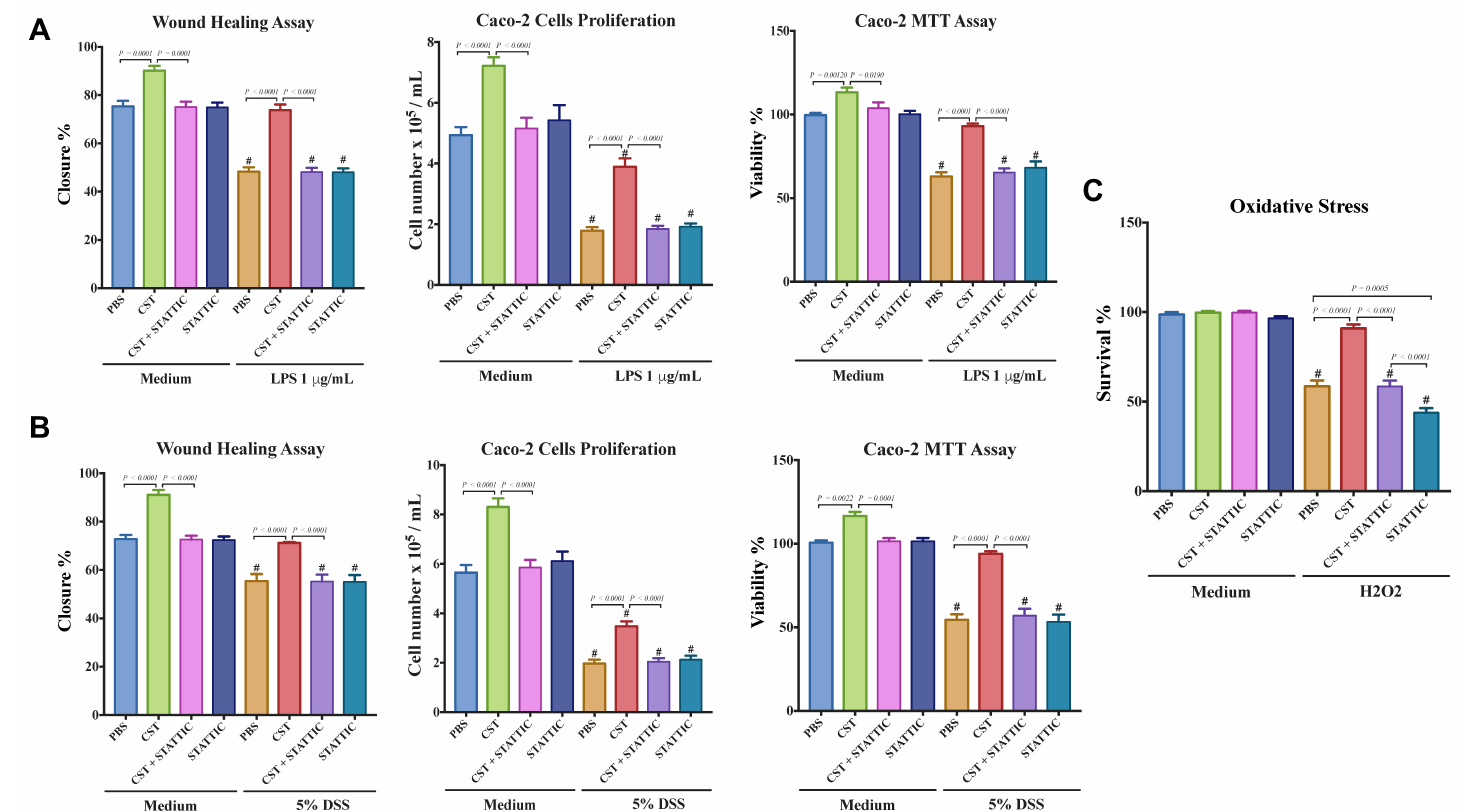
Figure 9. Catestatin (CST) enhances migration, proliferation, and viability of a colonic cell line in inflammatory conditions. Caco-2 cells were pretreated with 1 × phosphate buffer saline (PBS) or CST (100 ng/mL) for 24 h, then challenged with lipopolysaccharide (LPS) (1 µ g/mL) or 5% DSS) for an additional 24 h in the presence or absence of a STAT3 inhibitor (10 − 5 M, STATTIC; Sigma, Mississauga, ON, Canada). ( A , B ) Epithelial cell migration assessed by the wound healing assay, intestinal epithelial cell proliferation, and epithelial cell viability assessed by the 3-(4,5-dimethyl thiazolyl-2yl)-2,5-diphenyl tetrazolium (MTT) assay; ( C ) Epithelial cells oxidative stress assay show survival data from cultures treated with normal medium (control) or 200 mmol/L H 2 O 2 in the presence or absence of a STAT3 inhibitor (10 − 5 M, STATTIC; Sigma, Mississauga, ON, Canada). One-way ANOVA was used to analyze the data followed by multiple comparison tests. Data represent mean ± SEM ( n = 6). # Compared to control groups. Each experiment was repeated at least three